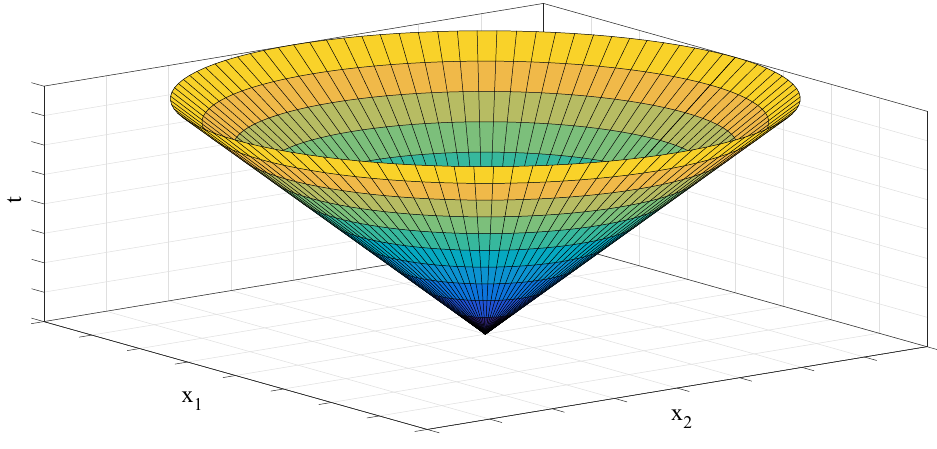
(cid:110) ( x , t ) ∈ R 2 × R : (cid:107) x (cid:107) ≤ t )